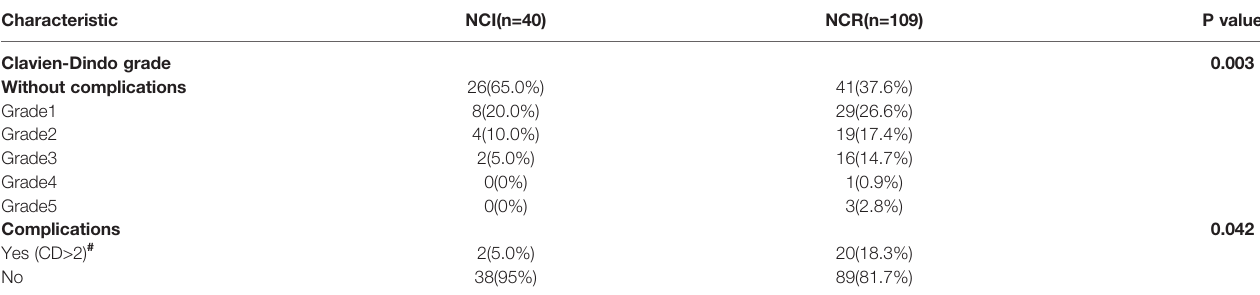
TABLE 5 | Perioperative complications.